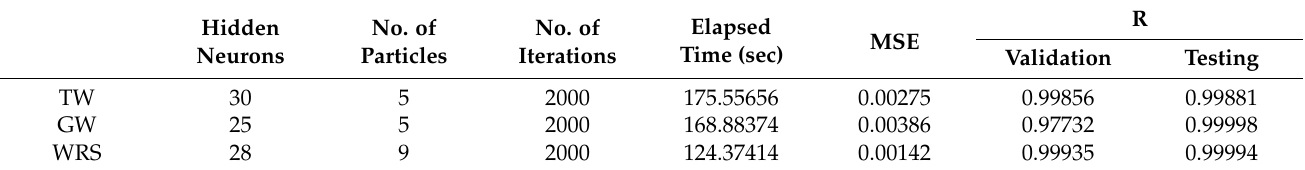
Table 13. NN-PSO simulation results for the HI (adults) mapping of domestic water samples.